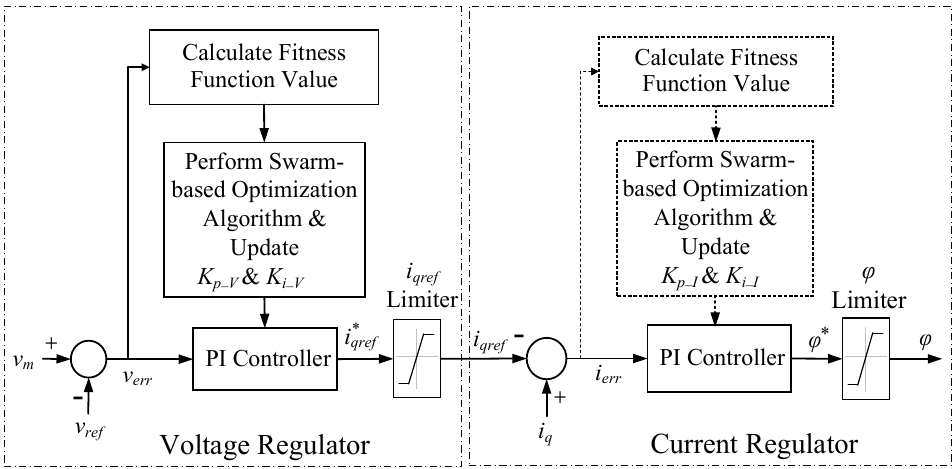
Figure 14. The proposed HHO-based PI controllers of STATCOM voltage and current regulators. The PI controller gains, K p and K i , are used in the voltage and current